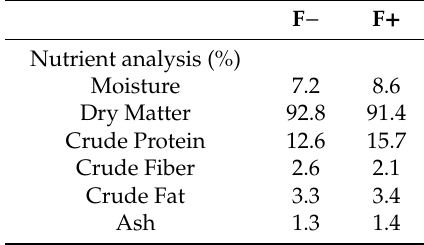
Table 1. Analyzed nutrient contents of P1-rr (F + ) and p1-ww (F − ).